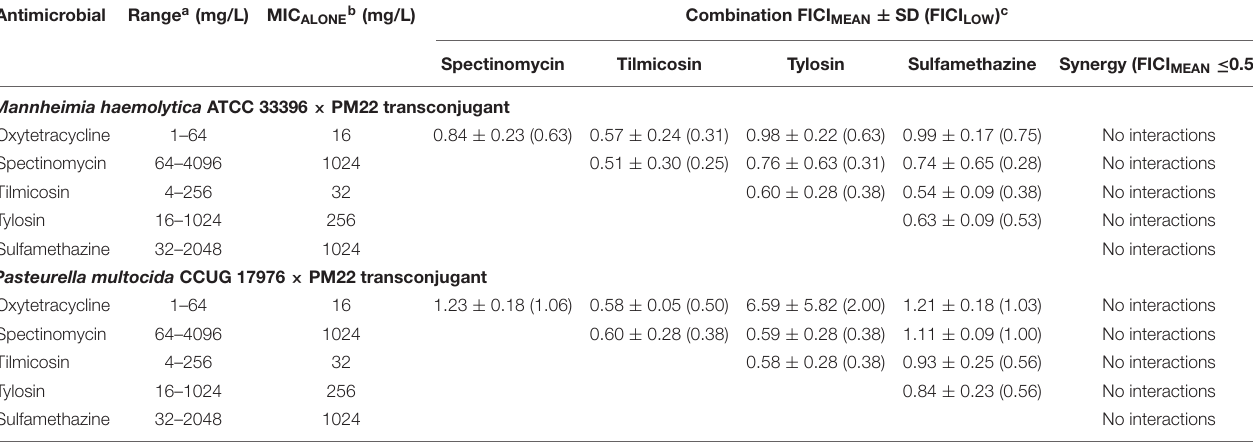
TABLE 2 | Results of checkerboard synergy testing (FICIs) with non-susceptible antimicrobial combinations. Antimicrobial Range a (mg/L) MIC ALONEb (mg/L)